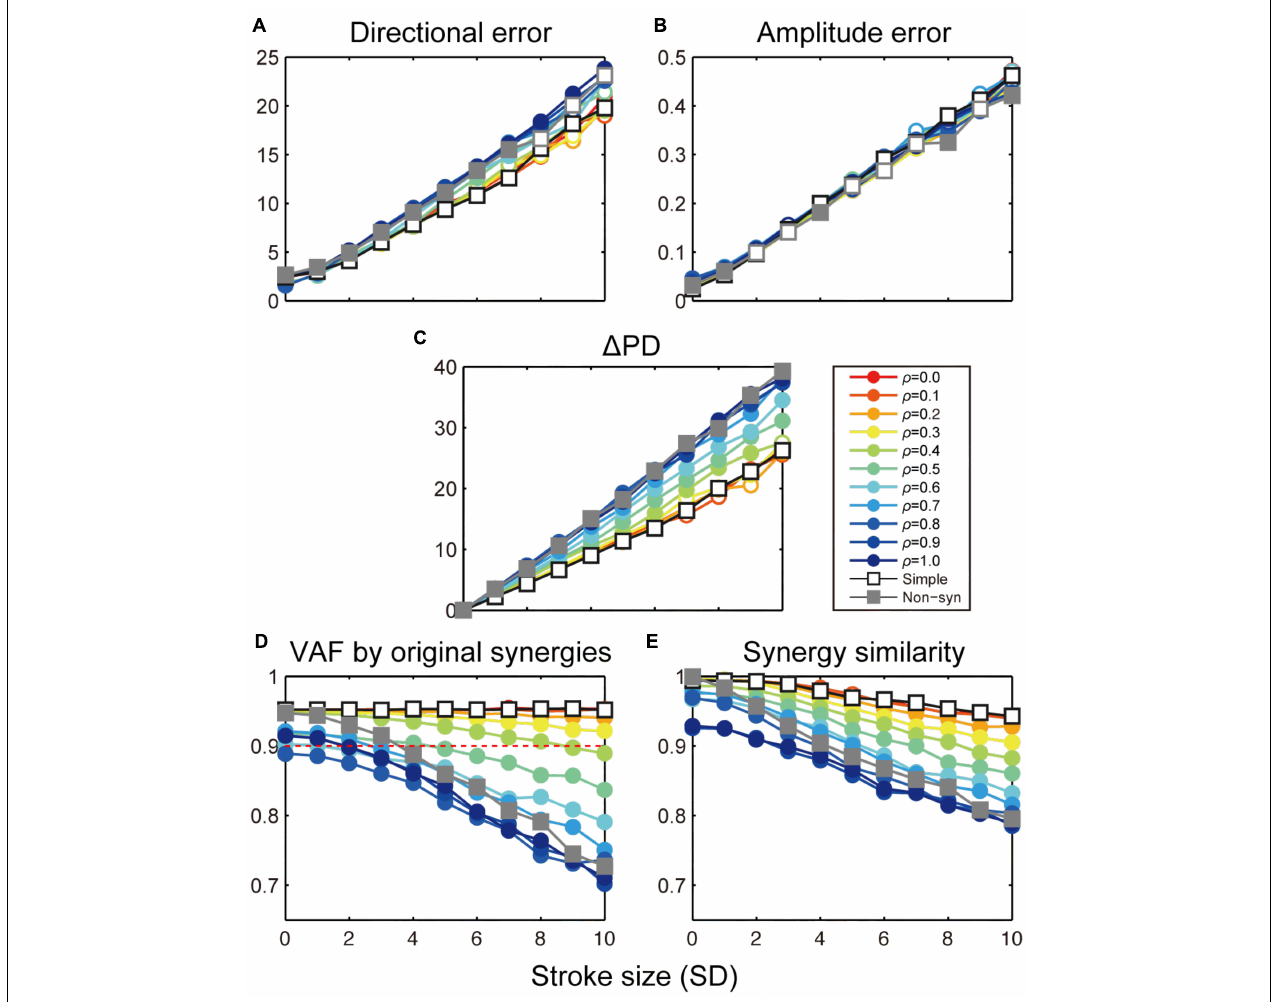
FIGURE 7 | Stroke effects on task performance and muscle synergies with simple and population synergy models. Change in directional error (A) , amplitude error (B) , shift of PD (C) , VAF by the original synergies (D) , and similarity with the original synergies (E) as a function of the size of cortical stroke (SD). Open and filled circles indicate a significant and non-significant difference from the simple synergy model (open square, p < 0.05, bootstrap test, n =